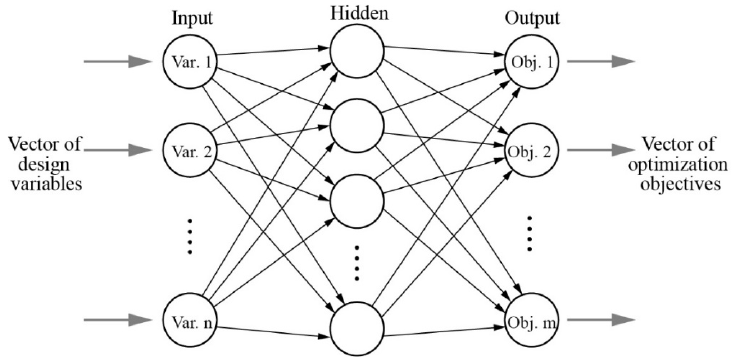
Figure 7. Structure of a three ‐ layer feedforward neural network.